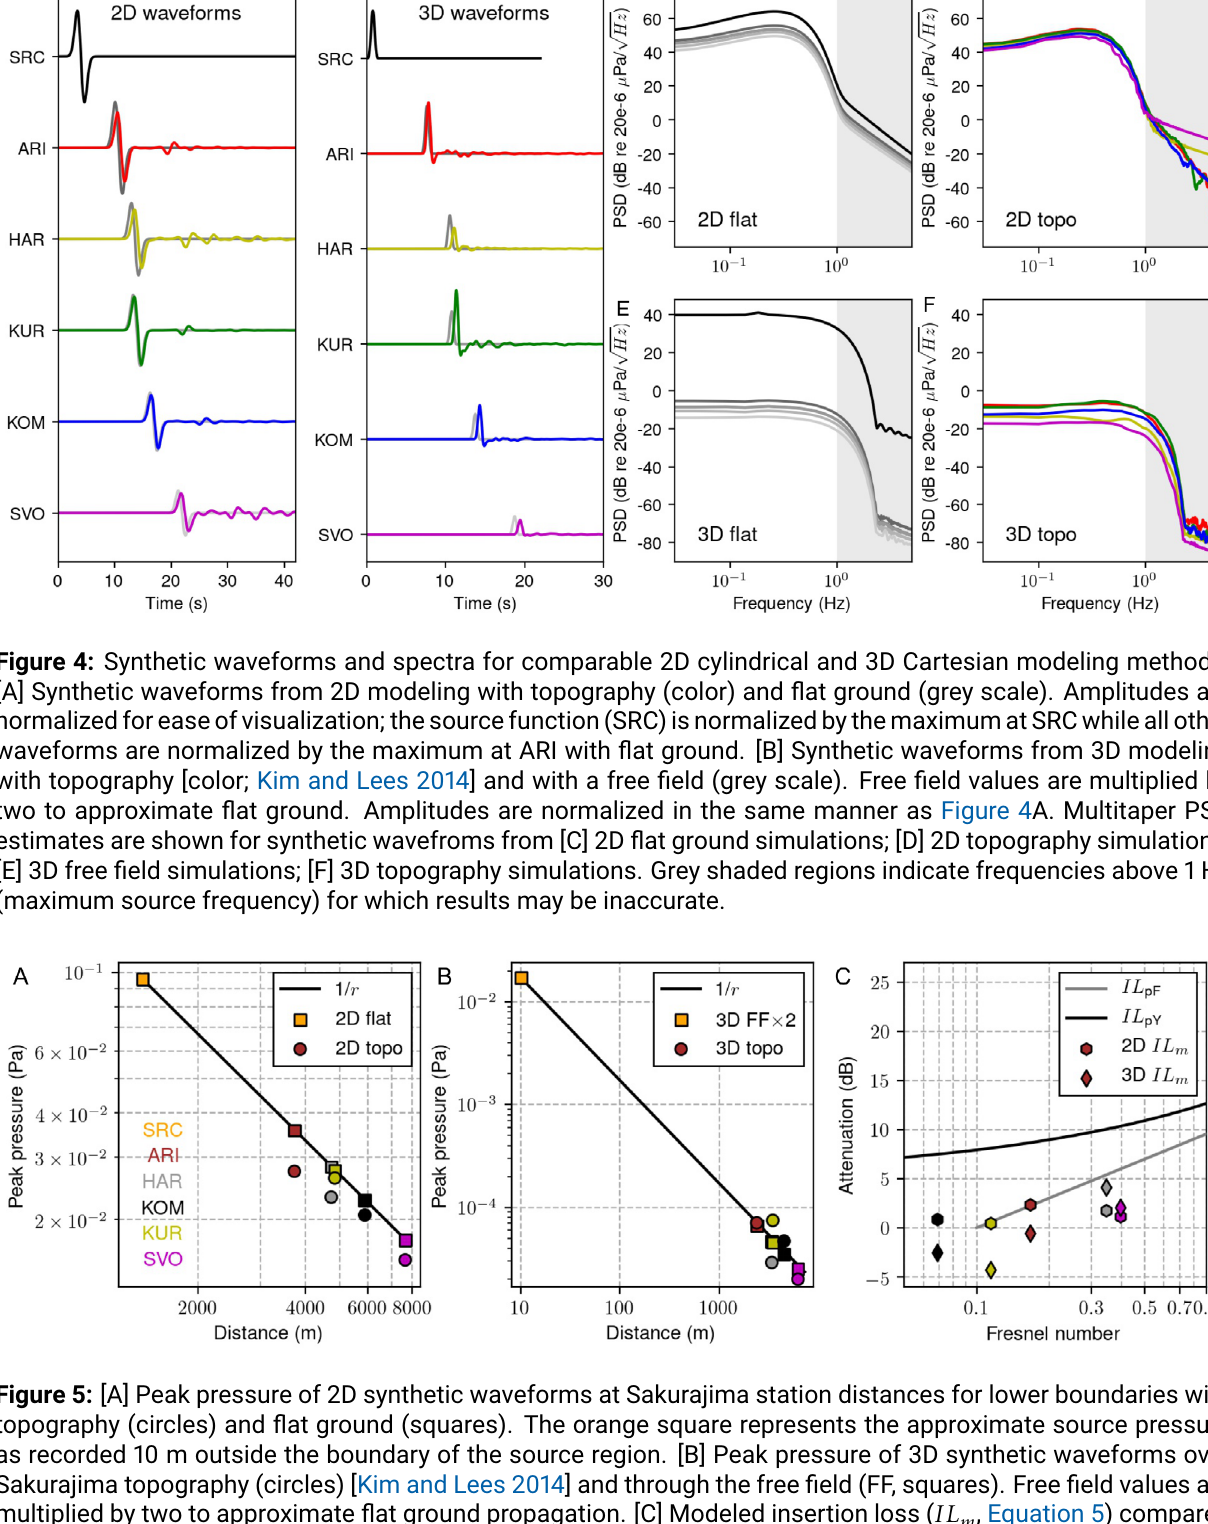
, Equation 5) compared m